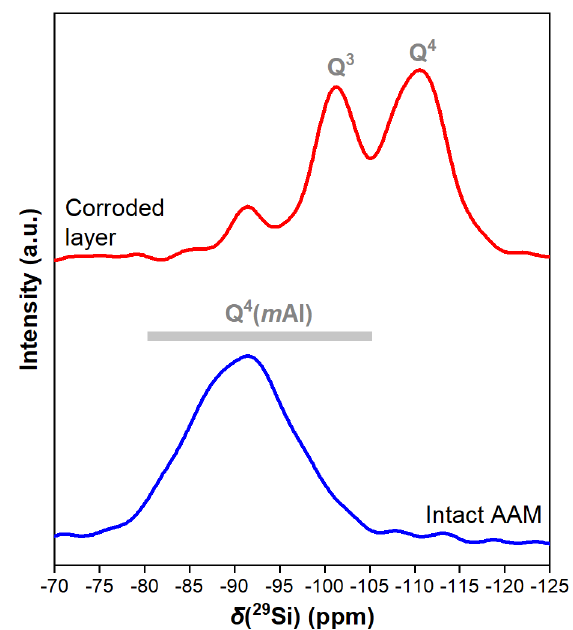
Figure 3. 29 Si MAS NMR spectra of an intact metakaolin ‐ based AAM and the corroded layer of the AAM after exposure to sulfuric acid. The Q 4 ( m Al) units with m = 1…4 in the intact material have mostly transformed to Q 3 and Q 4 units in the corroded layer. (Data from [22].)